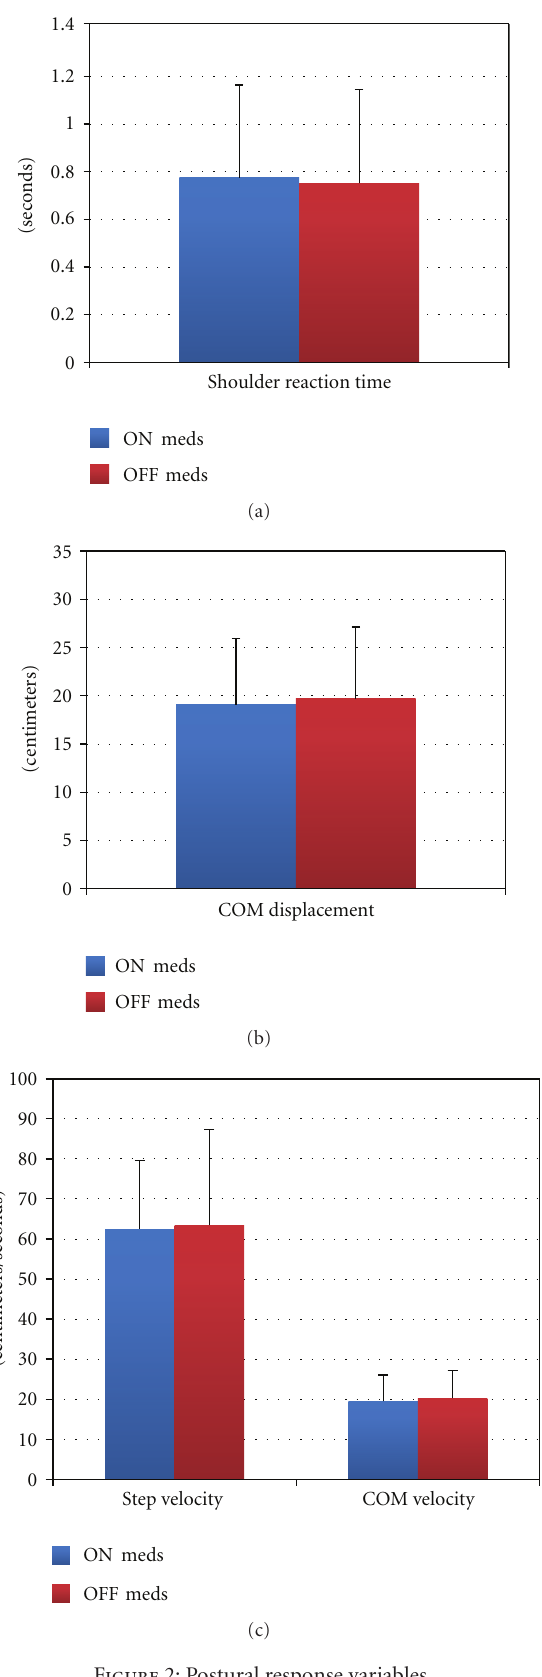
Figure 2: Postural response variables.